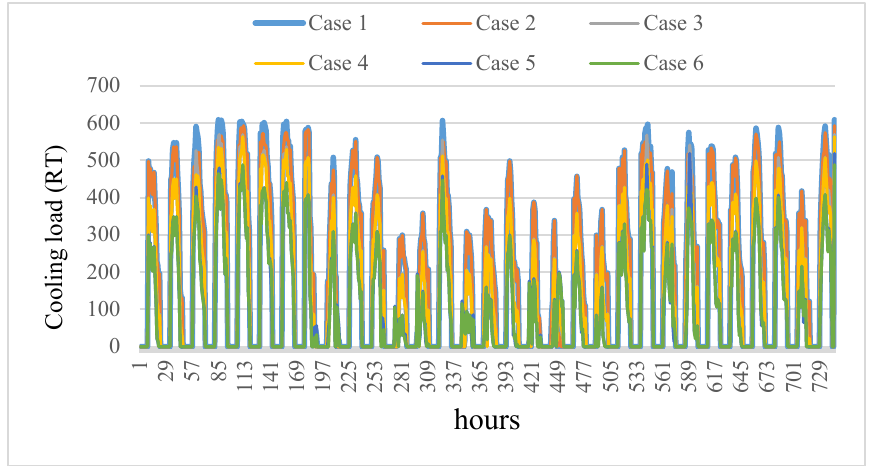
Figure 4. The cooling load of air-conditioner per hour in August 2020.